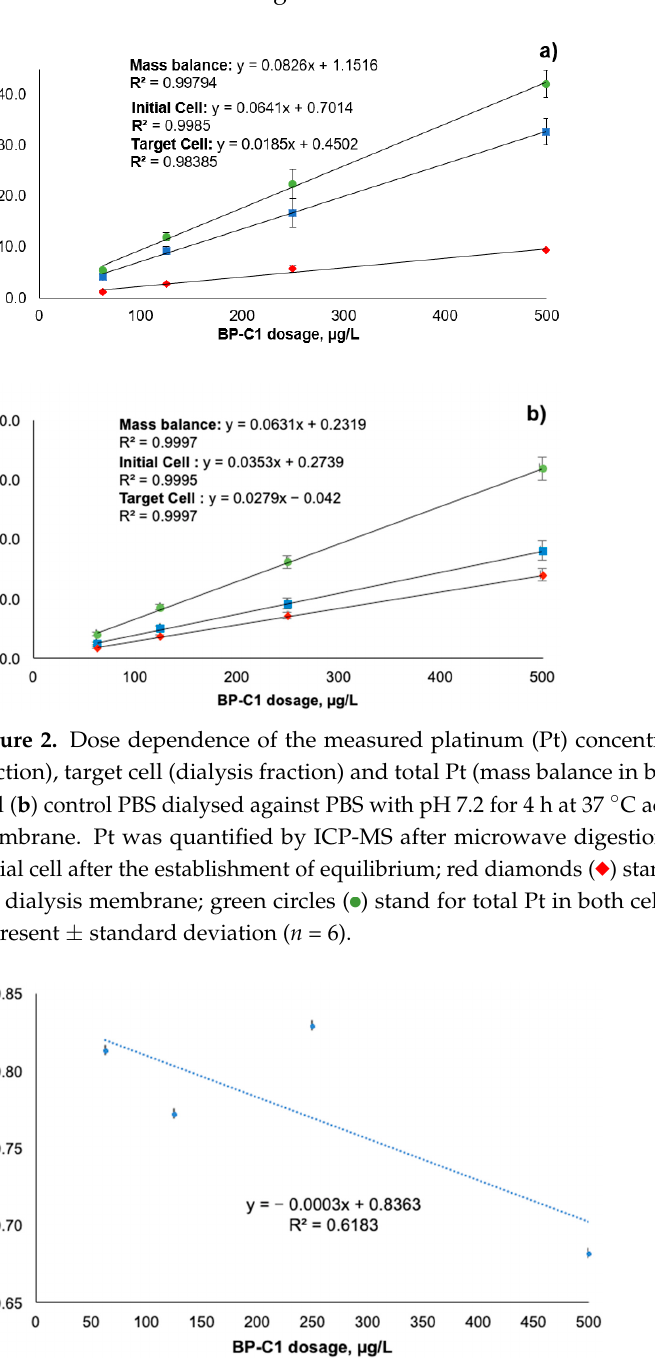
residual organic carbon in the plasma samples [30–33]. A good repeatability for parallel experiments (relative standard deviations, RSDs < 10%) was observed (Table 1). Signifi- cant retention of platinum for the control buffer after 4 h of dialysis is related to the mac- romolecular nature of the BP-Cx-1 ligand, reducing the pure drug’s capability to cross the 8 kDa membrane. This was additionally validated by independent experiments using dif- ferent dialysis durations (1–8 h, Supplementary Tables S1 and S2). The difference between 50% plasma at different dosage levels with a corresponding control PBS was evaluated, indicating a statistically significant difference (Table 1). Addi- tionally, average binding to macromolecular species in plasma and the control buffer were calculated to be 76.5 ± 6.0% and 57.6 ± 5.0% (±standard deviation, SD), respectively. Taking into account the dilution of initial plasma 1:2 per volume with PBS before dialysis, the following fractions of ‘free’ (unbound to macromolecules) platinum were calculated: 42.4 ± 5.0% and 11.8 ± 3.0 % (±SD) for the control buffer and plasma, respectively. Considering the macromolecular nature of the BP-C1 lignin-derived ligand (average molecular weight of 1500–2000 Da [7]), the contribution of binding to plasma proteins may be considered to be ca. 60% (61 ± 12%, ±2 SD, n = 24), since ca. 15% of Pt is associated with polyphenolic moieties, as identified by the control buffer experiments (see Supplementary Information for more details on calculations). Platinum-based drug plasma protein binding is known to be lower for drugs con- taining O-donor leaving ligands. For instance, carboplatin mostly releases active platinum moiety only intracellularly, showing ex vivo binding of 25–40% [34,35]. Previous studies of platinum drug binding to plasma/serum proteins indicated that carboplatin is primar- ily bound to HSA (45–96%, depending on incubation times), followed by transferrin and immunoglobulin-G (both ca. 2%) [16,36]. In vivo studies indicated the formation of re- versible complexes of carboplatin with HSA [37]. Nevertheless, the intracellular distribu- tions of cisplatin and carboplatin are similar, and their exhibited toxicity is not directly correlated with a total platinum concentration in target organs [38]. This is consistent with our previous studies for BP-C1 and other platinum drugs, indicating a high level of total